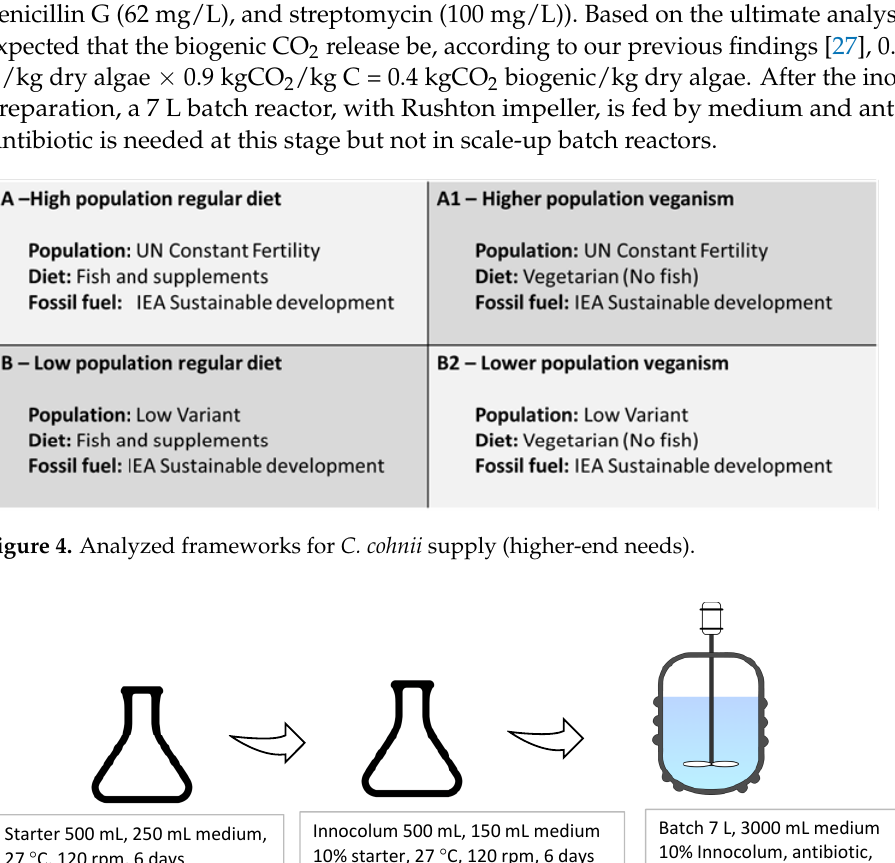
Figure 5. Cultivation step. Starter, inoculum, bench-scale batch reactor.